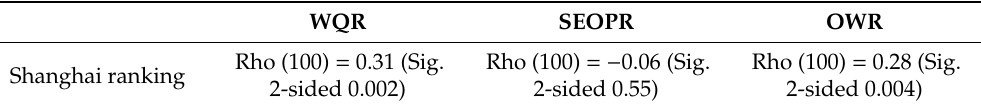
Table 12. The use of flat weights in the calculation of Spearman correlation coe ffi cient between the ARWU, website quality ranking (WQR), SEO performance ranking (SEOPR), and overall web ranking (OWR). WQR SEOPR OWR Rho (100) = 0.31 (Sig. Shanghai ranking 2-sided 0.002)